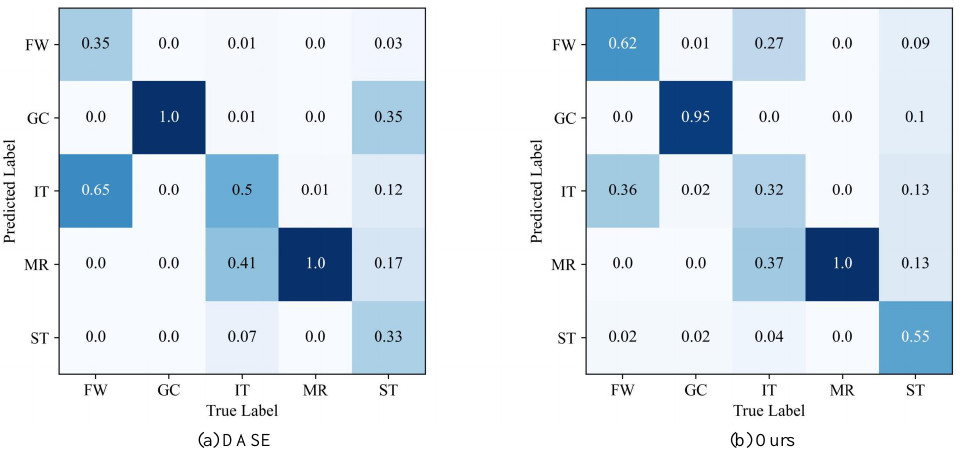
Figure 4. Confusion matrix of the two methods on the UCM21 dataset. Where “FW”, “GC”, “IT”, “MR”, and “ST” denotes “freeway”, “golf course”, “intersection”, “medium residential”, and “storage tanks”, respectively.